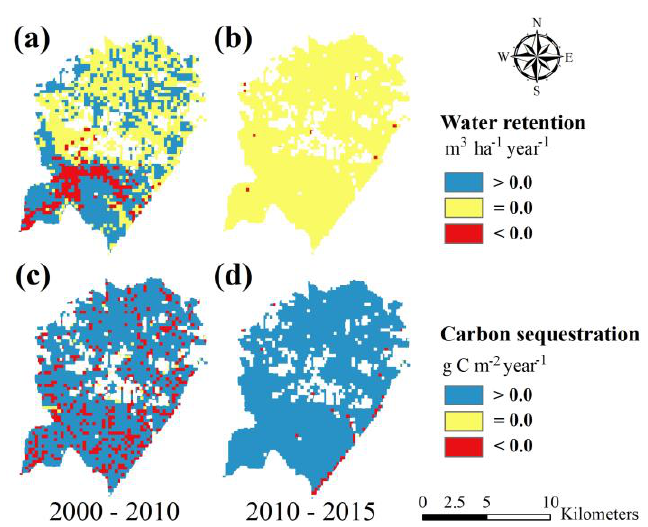
Figure A1. Mean temperature, precipitation and relative humidity for the Huangshan UNESCO Global Geopark.